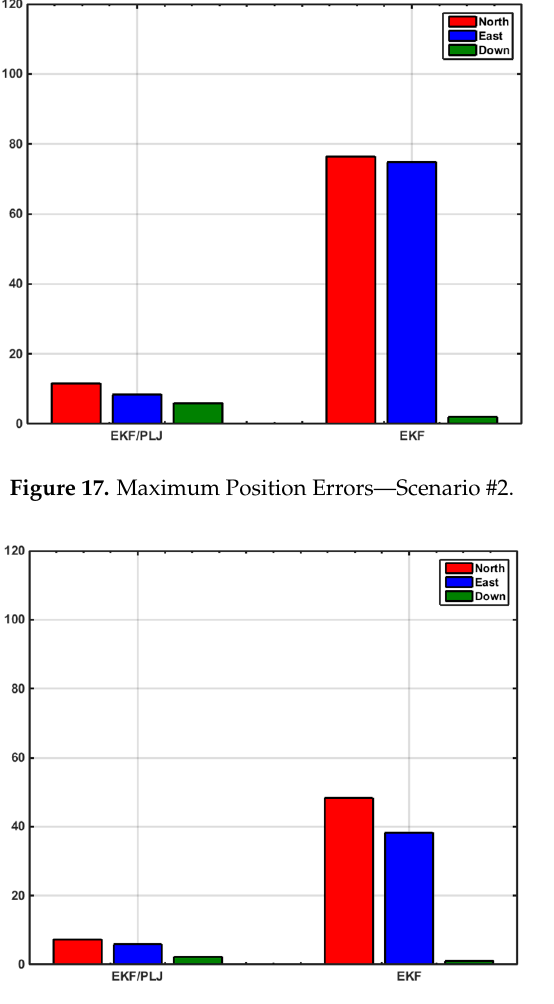
Figure 16. Positions Errors—EKF & EKF/PLJ Scenario #2.